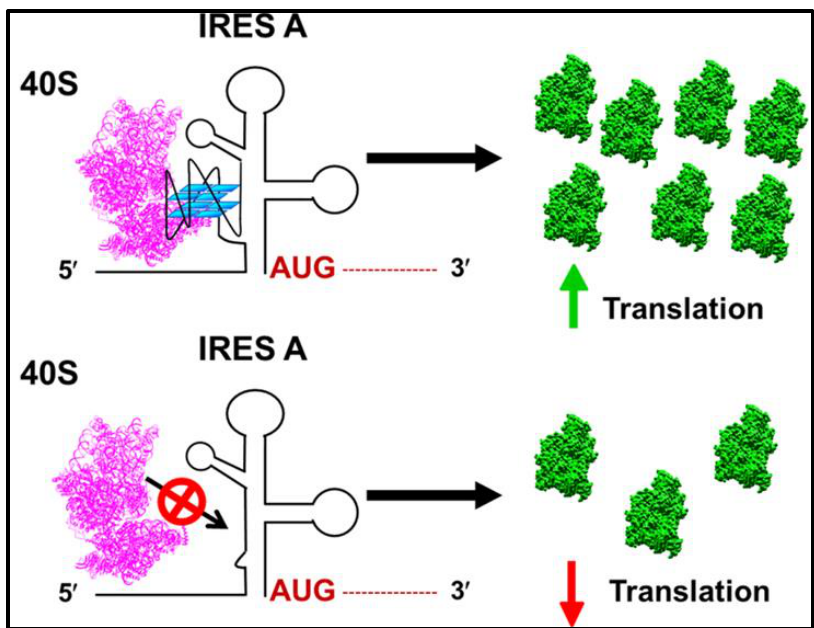
Figure 3. Schematic representation of direct recruitment of the 40S ribosomal subunit by G-quadruplex structures to drive cap-independent translation initiation. Adapted with permission from Bhattacharyya et al., ACS Biochemistry [79].